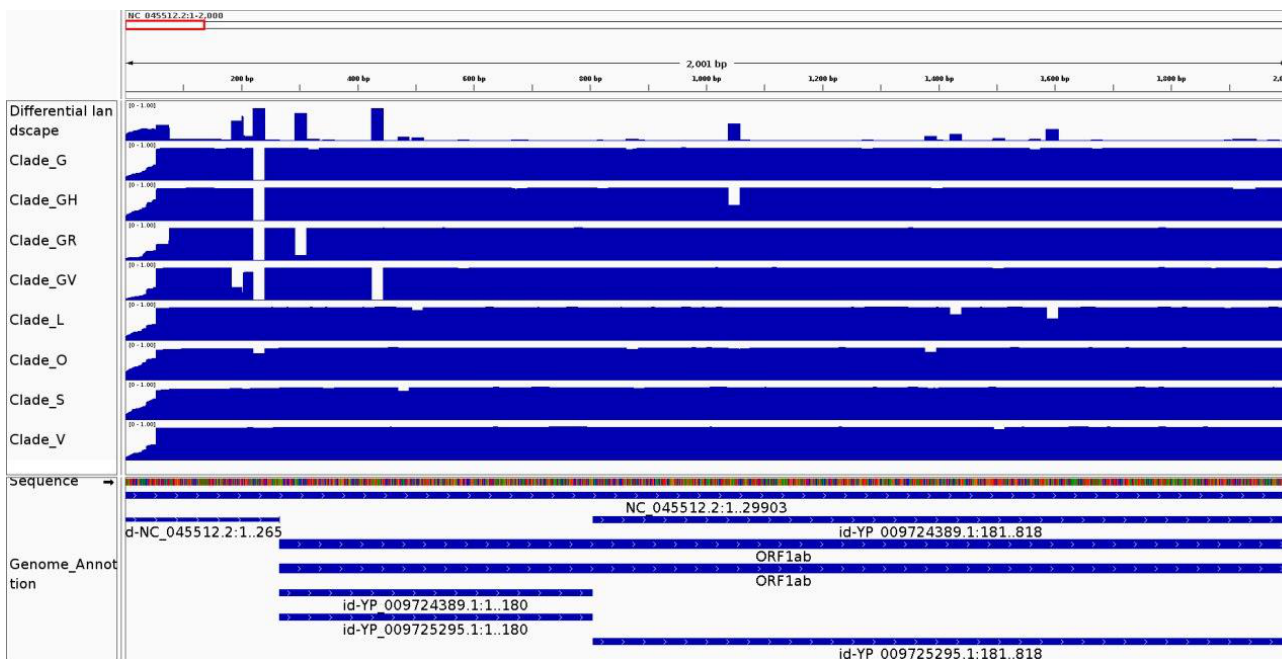
Figure 4. Conservation and differential landscapes for each SARS-CoV-2 clade. The visualization generated by CovDif via IGV for the genomic interval 1–3500 is shown. Top track: differential land- scape showing the biggest difference between the all groups; middle tracks: conservation landscape for each SARS-CoV-2 clade (according to GISAID) and bottom track: SARS-CoV-2 annotation .